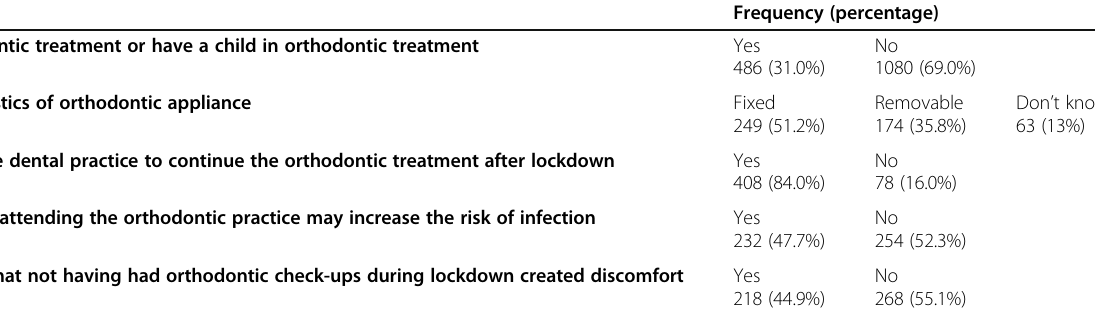
Table 3 Frequencies and percentages of replies to questions about orthodontics In orthodontic treatment or have a child in orthodontic treatment